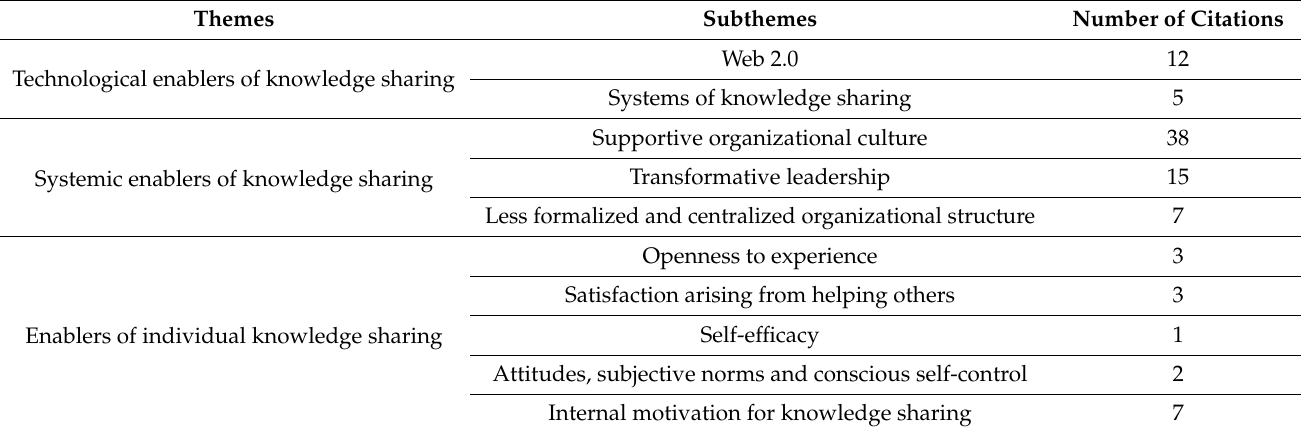
Table 3. Synthesis of identified themes in knowledge management literature (source: own